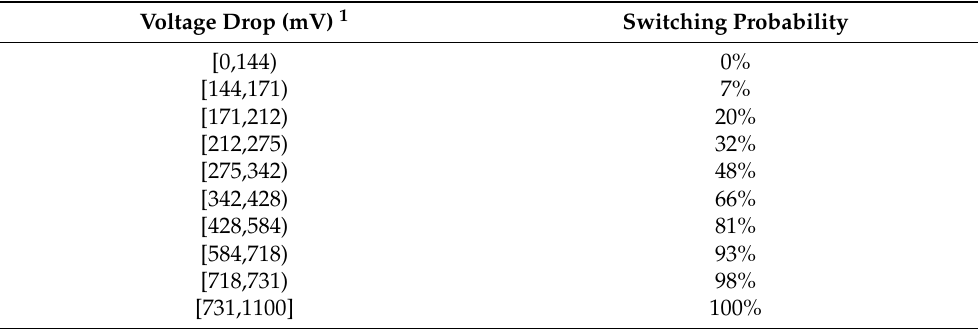
Table 2. The relationship between the voltage drop of the MTJ and the probability of switching from a low-resistance state to a high-resistance state.